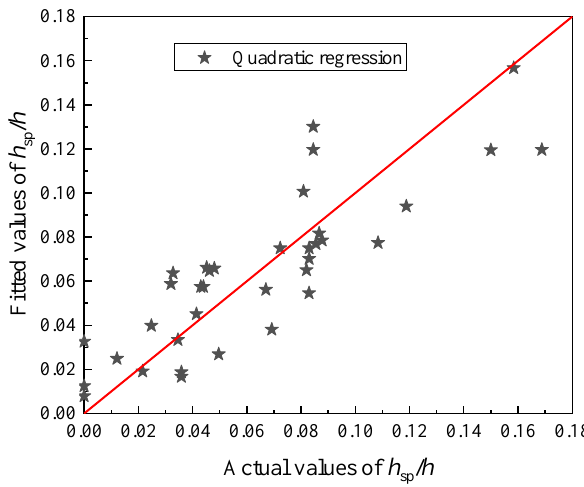
Figure 10. The comparison of actual values and fitted values for the dimensionless soil plug h sp / h.